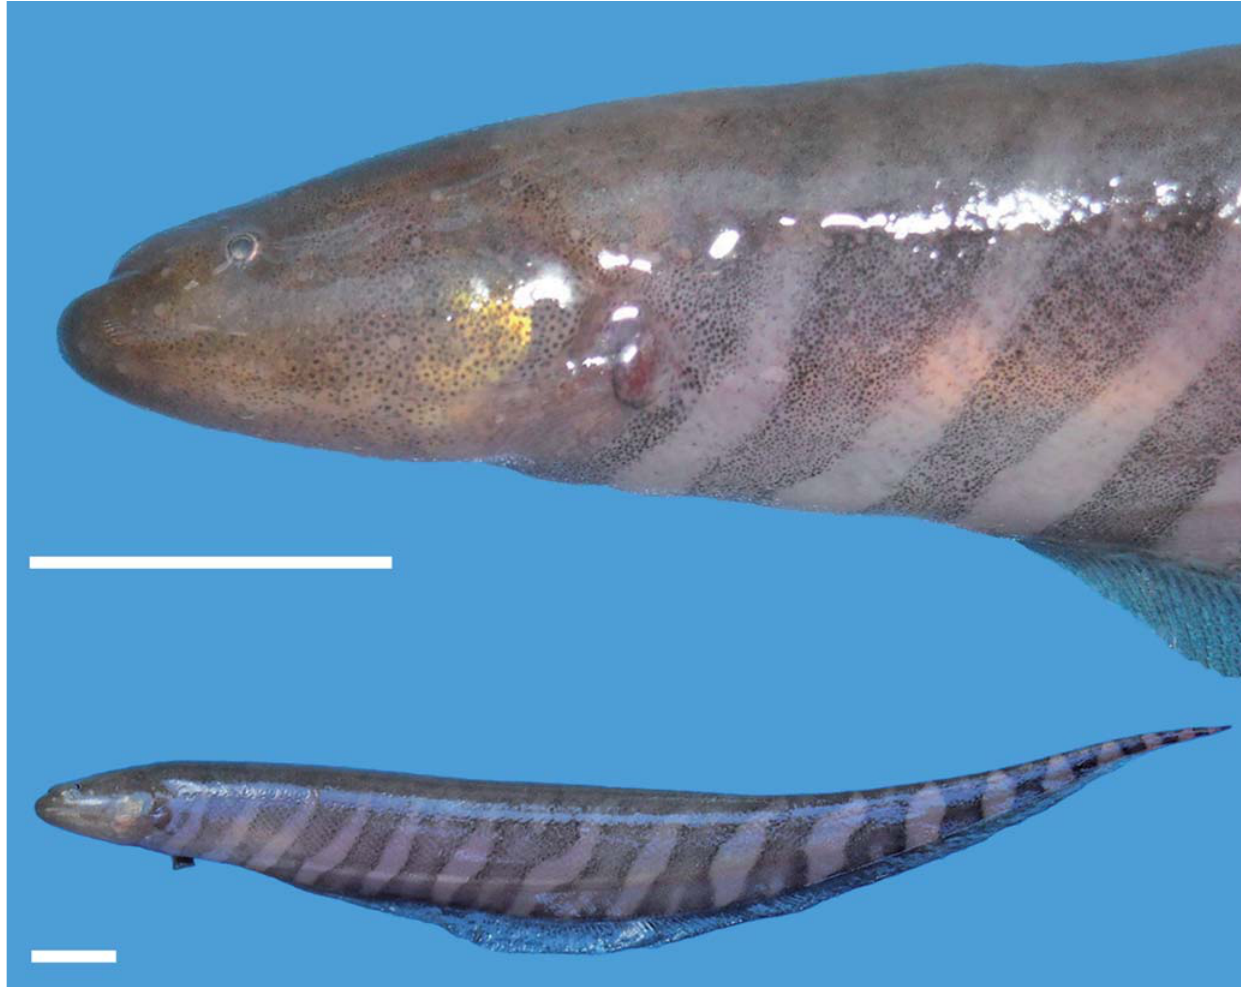
Fig. 2. Gymnotus chaviro , paratype, MUSM 33714, 150 mm TL. (a) head, (b) body. Scale bars = 10